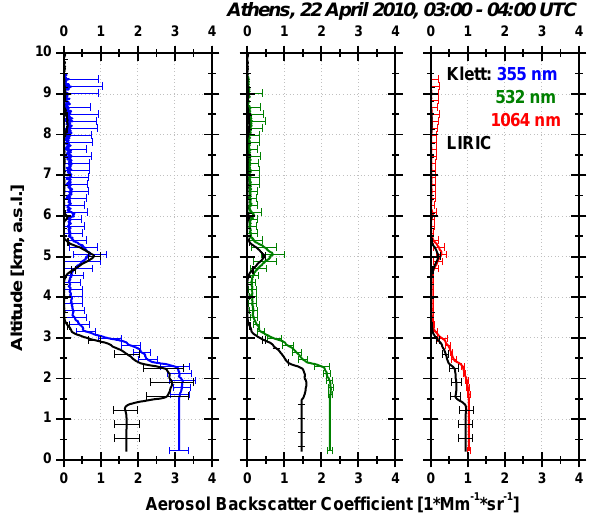
Fig. 5. Coarse mode, fine mode and total concentrations retrieved by LIRIC versus ash concentration (in µgm − 3 ) simulated by FLEX- PART for 22 April 2010 (03:00UTC) over Athens.